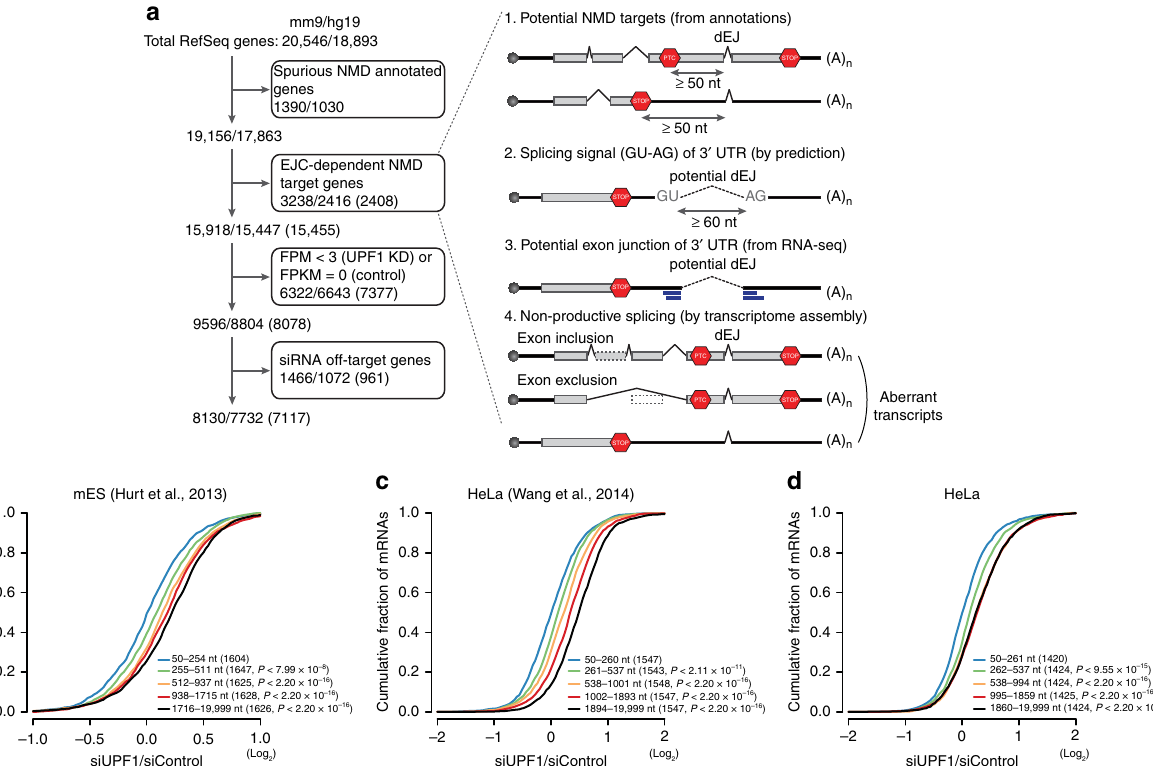
Fig. 1 UPF1-responded genes. a Shown is the schematic fl ow for selecting dEJ-free genes, comprising four fi ltering steps (see “ dEJ-free genes ” in the Methods section for additional details). The top slash-delimited numbers indicate the RefSeq genes for humans (hg19) and mice (mm9). The following slash-delimited numbers indicate genes remaining from each indicated step, and the numbers in boxes indicate genes excluded at each indicated step. From the third step, only expressed genes were considered by quantifying their expression values (FPMs and FPKMs) with mES RNA-seq data 31 , with HeLa RNA-seq data 35 and our experiment (parenthesis), in order. Red stop sign, stop codon in potential NMD targets; paired thick blue line, RNA-seq-supported exon junction read; dotted line, potential exon junction; dotted box, exon exclusion; dark-gray solid box, exon inclusion. b – d Cumulative fractions of log 2 changes in the expression of genes in siUPF1-treated cells against siControl-treated cells are shown as cumulative distribution function (CDF) graphs of Hurt et al. ’ s mES cell data ( b ), Wang et al. ’ s HeLa cell data ( c ), and our HeLa cell data ( d ). The numbers in parentheses are dEJ-free genes without off- target sites of siRNAs belonging to each 3 ′ UTR length bin. The P values were estimated by the Kolmogorov – Smirnov (K – S)